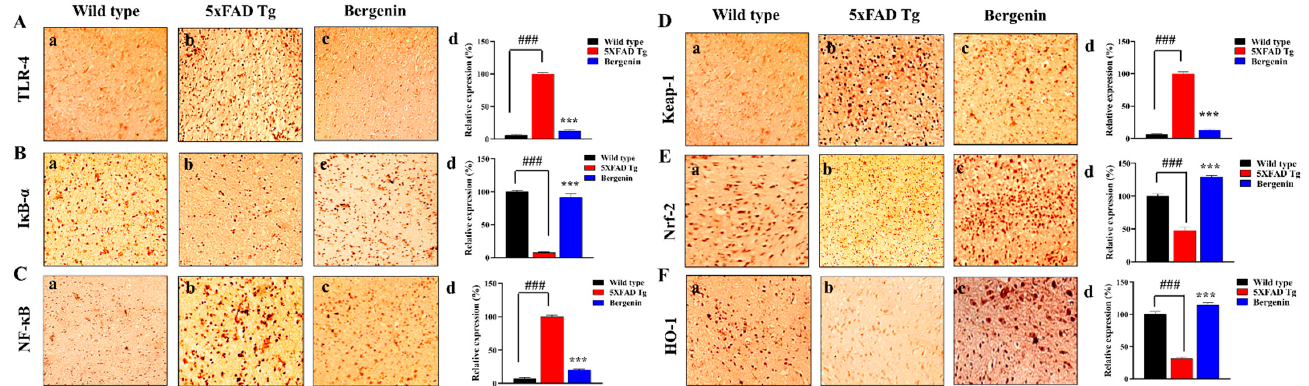
Figure 9. Immunohistochemical (IHC) analysis of ( A ) TLR-4, ( B ) I κ B- α and ( C ) NF- κ B proteins in the hippocampal region of ( a ) wild-type, ( b ) 5xFAD Tg, and ( c ) Bergenin-treated groups, ( d ) quantitative analysis of (%) relative expression of proteins. Immunohistochemical analysis of ( D ) Keap-1, ( E ) Nrf-2, and ( F ) HO-1 in hippocampal regions of mouse brains in ( a ) wild-type, ( b ) 5xFAD Tg, and ( c ) Bergenin-treated groups. ( d ) Represents the quantitative analysis of (%) relative expression of proteins. Scale bar = 50 µm. Results were expressed as mean ± S.D. *** p < 0.001 versus the 5xFAD Tg mice group, ### p < 0.001 versus the wild type.